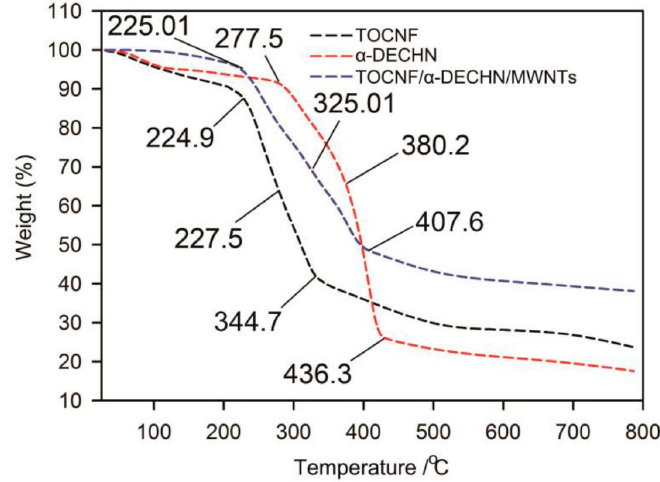
Figure 17. TGA profiles of TOCNF, α -DECHN, and TOCNF/MWCNT/ α -DECHN [85]. As the temperature rises, the difference between the weight loss percentages of TOCNF/MWCNT/ α -DECHN composite wire and α -DECHNs is steadily diminished. This observation specifies that in the composite wire, TOCNF decomposes at a lower temperature than α - DECHNs.